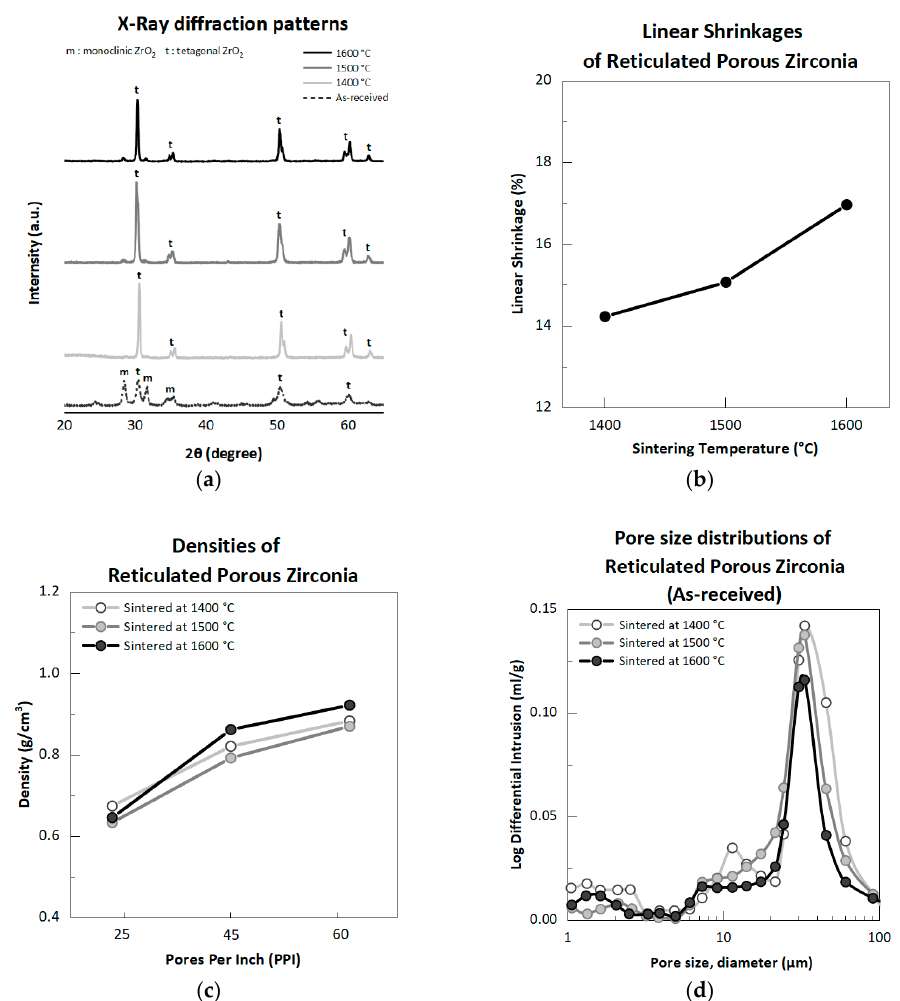
Figure 6. ( a ) X-ray diffraction patterns of the reticulated porous zirconia with different sintering temperatures, ( b ) linear shrinkage levels, ( c ) densities, and ( d ) pore size distributions of the reticulated porous zirconia samples when sintered at 1400, 1500, and 1600 °C .